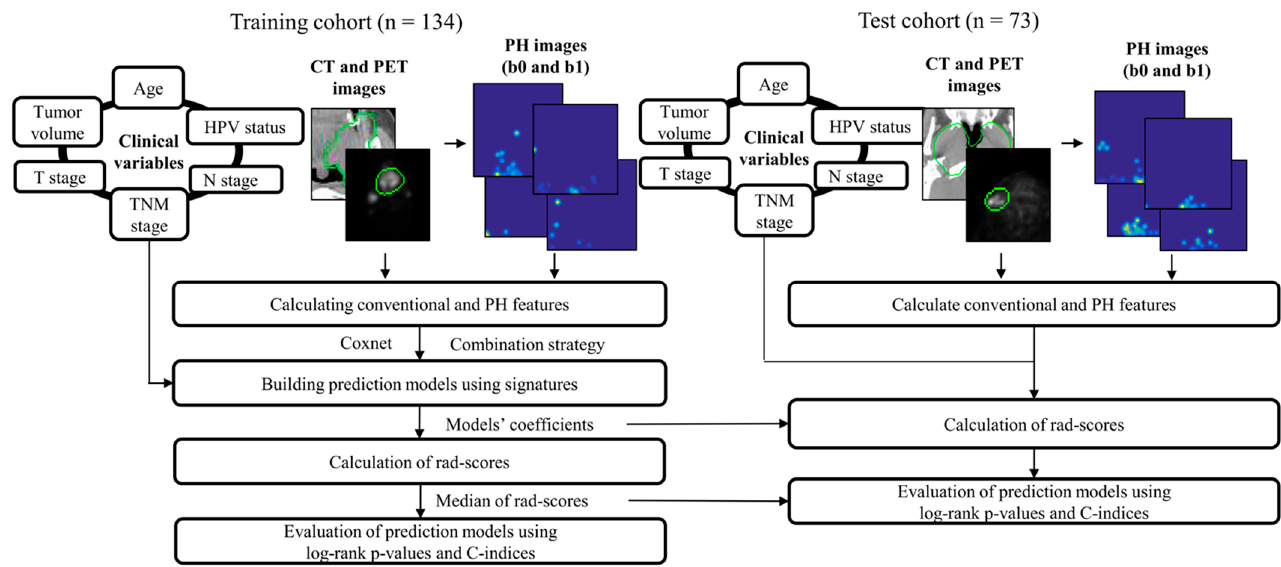
Figure 1. Overall workflow employed in this study. PH: persistence homology, HPV: human papilloma virus; CT: computed tomography; PET: positron emission tomography; rad-score: radiomic score; the green circle represents gross tumor volume.